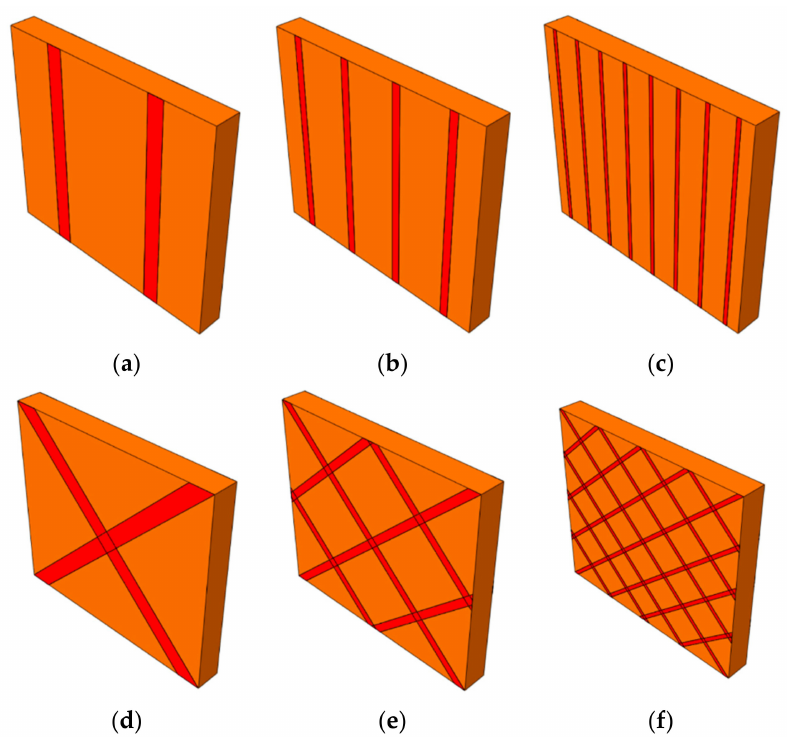
Figure 12. Numerically studied walls, ( a ) UMW2, ( b ) UMW3, ( c ) UMW4, ( d ) UMW5, ( e ) UMW6, and ( f )